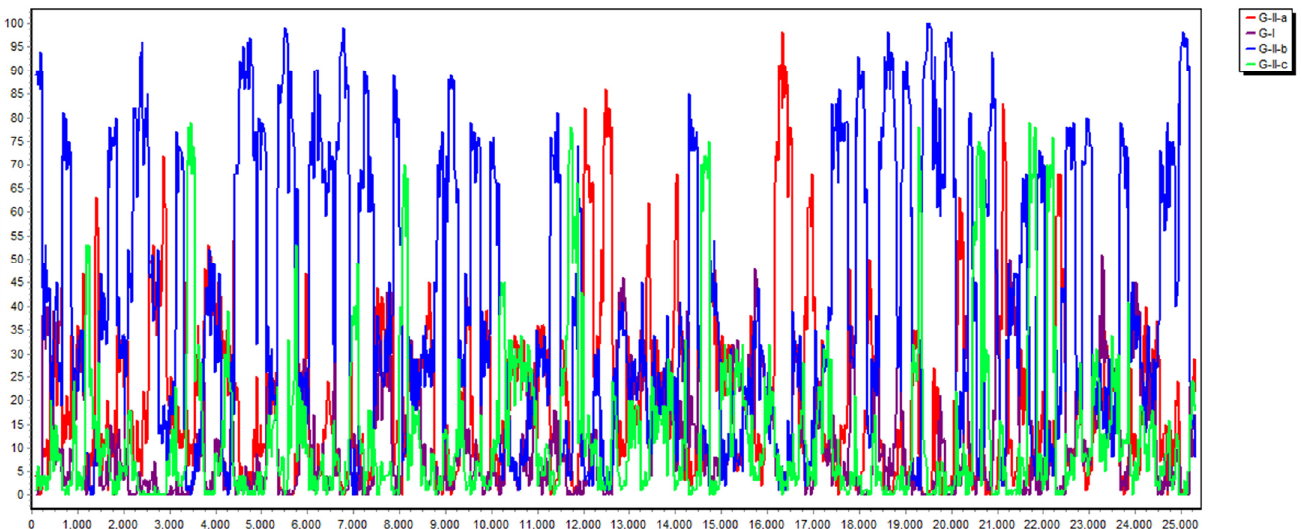
Figure 4. Analysis of recombination events between the local PDCoV isolate and other genogroups (G-I, G-II-a, G-II-b and G-II-c) based on the neighbor-joining method in the K2P model, using the SimPlot assay.